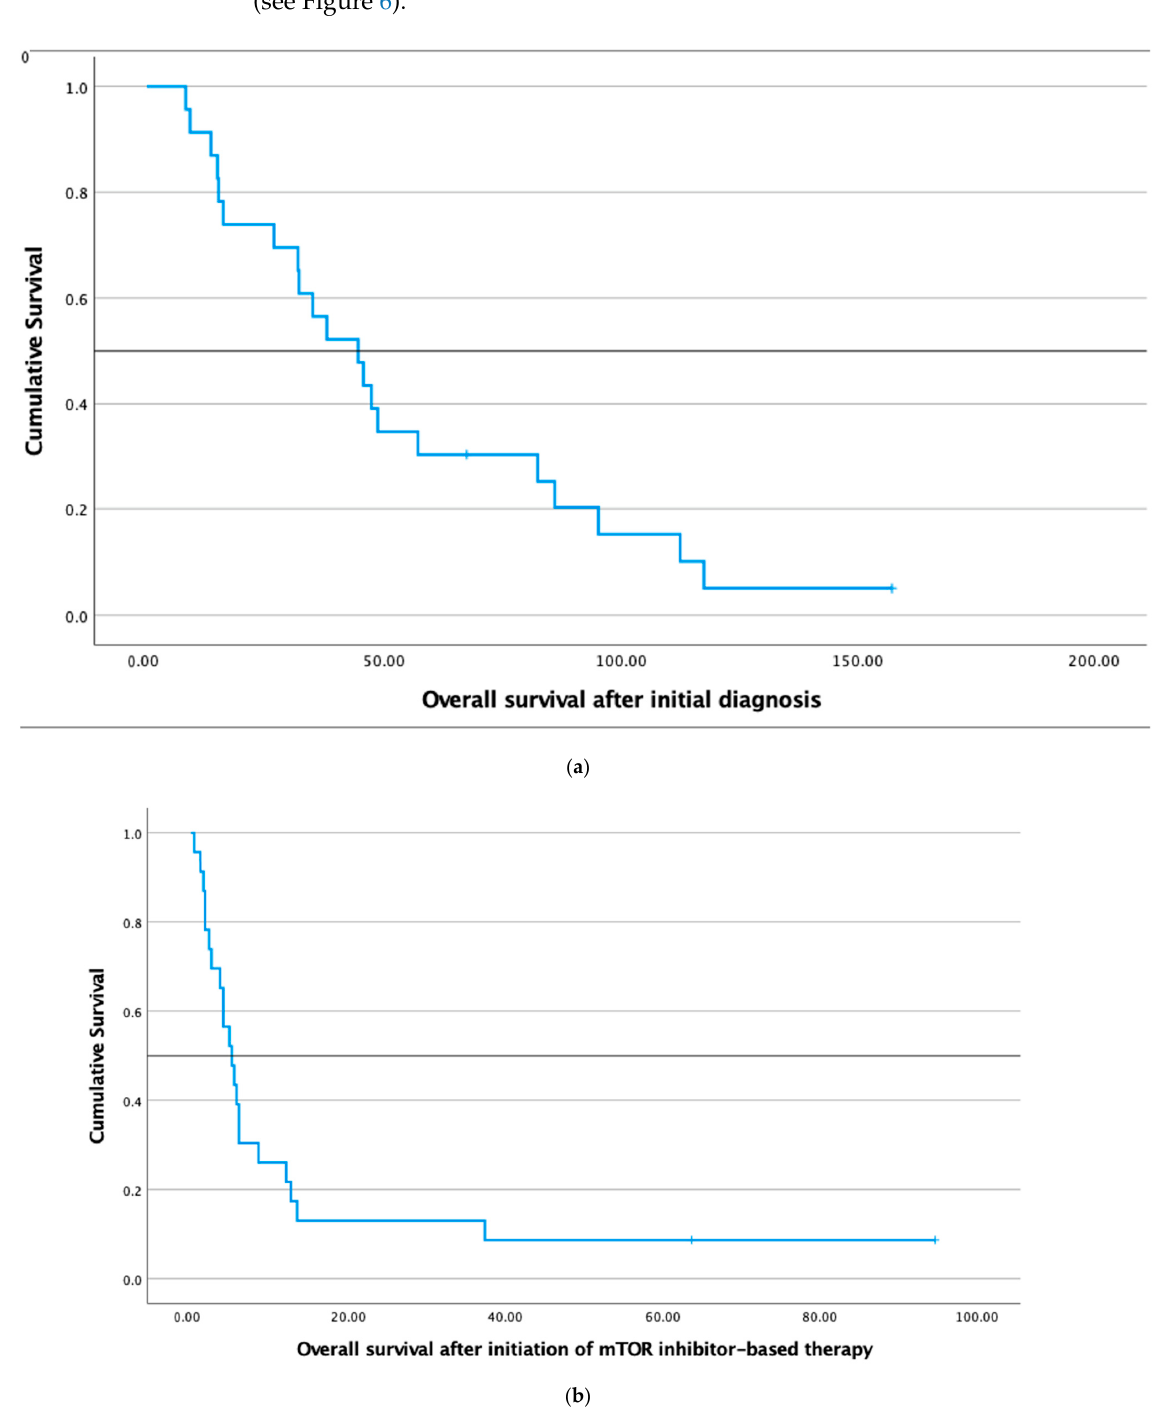
Figure 6. ( a ) Kaplan–Meier survival curve demonstrating overall survival (OS) after initial diagnosis of the solid tumor and ( b ) Kaplan–Meier survival curve showing OS after the beginning of the mTORC1-inhibitor-based therapy in 23 patients.